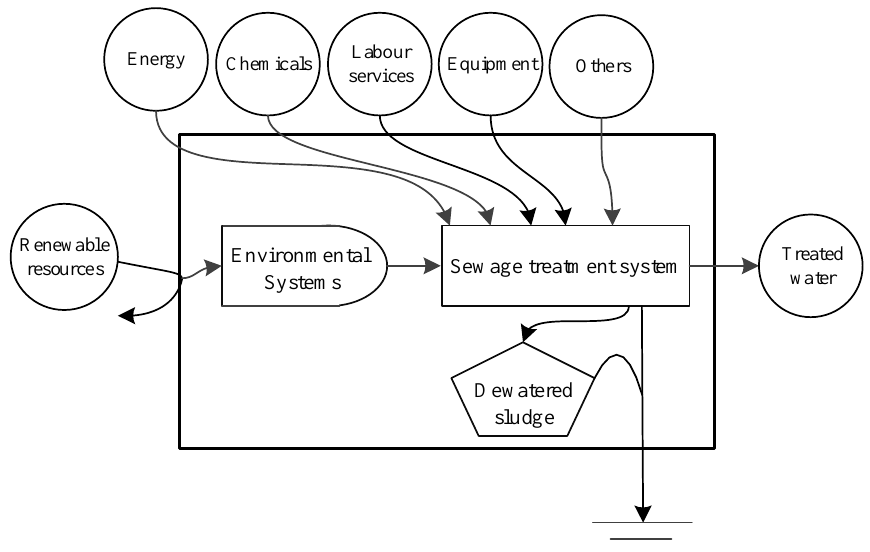
Figure 1. Diagram of the wastewater treatment ecosystem emergy analysis system.